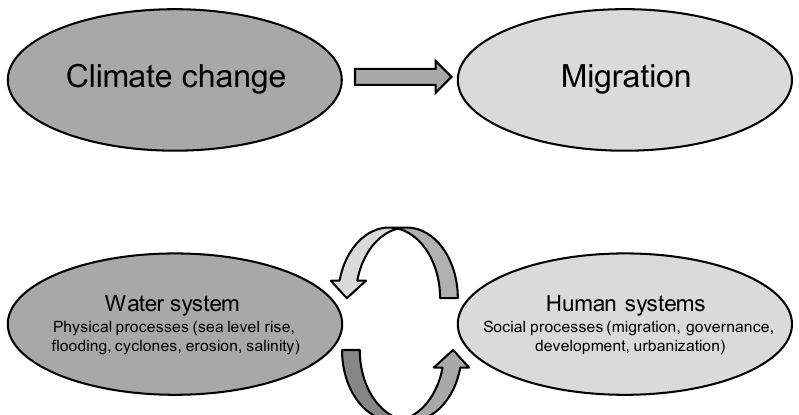
Fig. 3 Example of current narratives [top] and proposed research framework